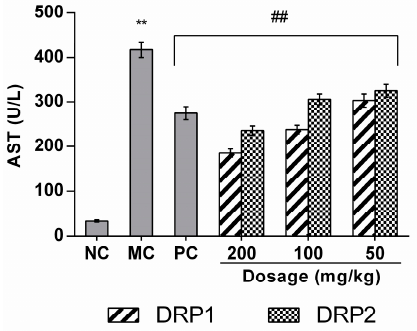
Figure 6. Effects of DRP1 and DRP2 on serum AST levels. The values presented are the mean ± S.E.M. (n = 10 in each group). ** p < 0.01 compared with NC group; ## p < 0.01 compared with the MC group.